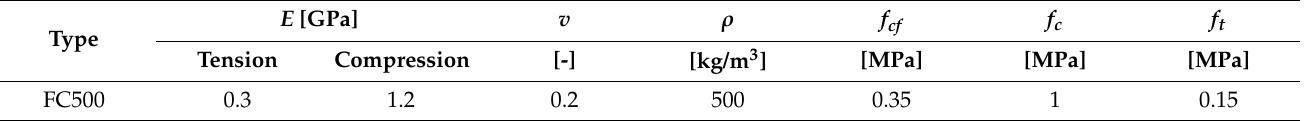
Figure 10. Schematic dependance of the analytical load test used.